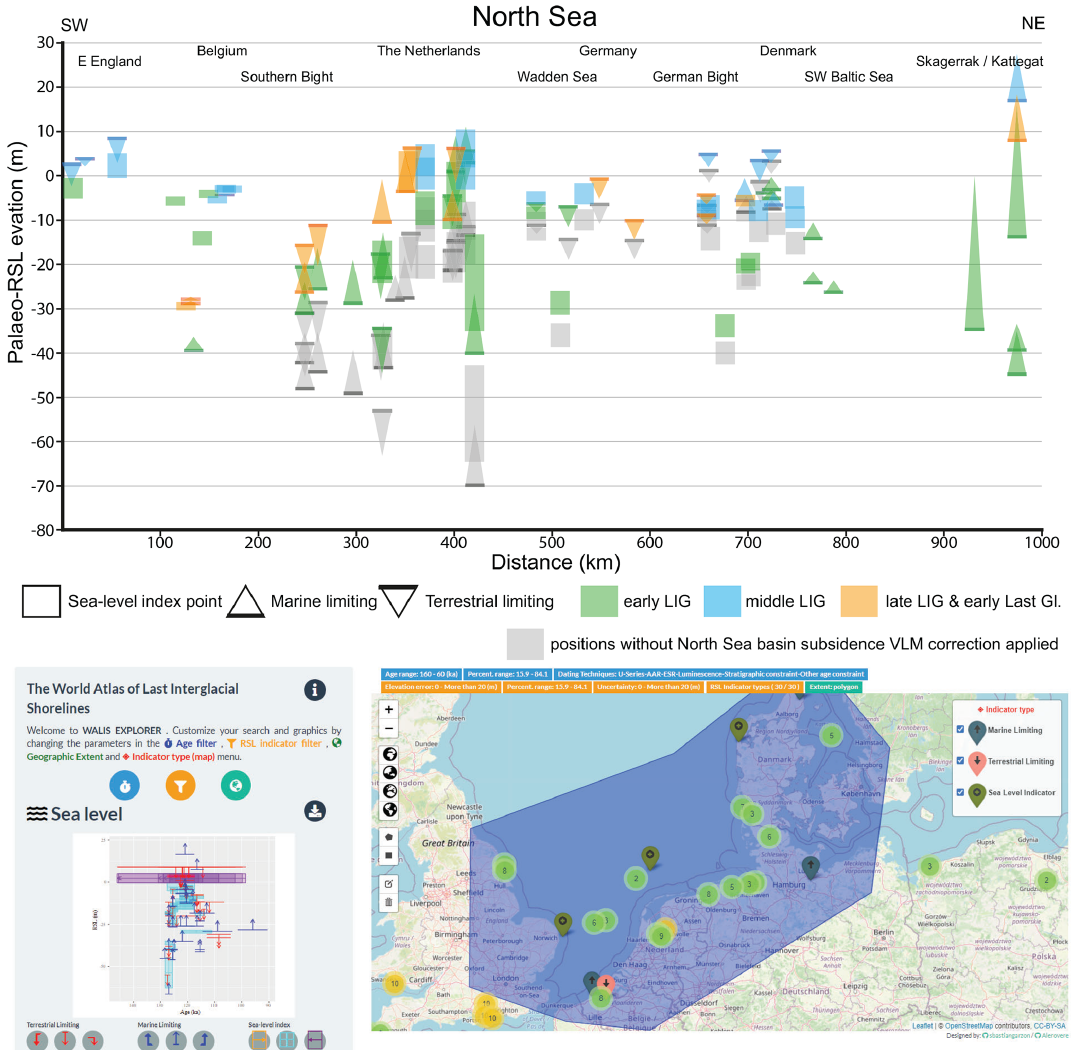
Figure 4. SW–NE-organised plot of Last Interglacial WALIS data entries for the North Sea, split into type and relative position. Transect location in Fig. 1. Colour coding separates data points of middle-LIG relative age from those attributed to earlier and later phases within the LIG (see also Table 1). Bottom panels show sites and age–depth plot (without VLM corrections) as a screenshot of WALIS’ visualisation interface (Garzon and Rovere, 2021): https://warmcoasts.eu/world-atlas.html (last access: 30 April 2022), which includes data as basemap © OpenStreetMap contributors 2020. Distributed under the Open Data Commons Open Database License (ODbL) v1.0. Only LIG data points are